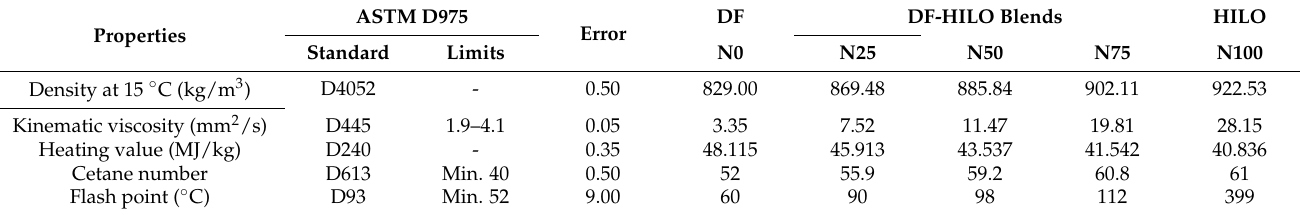
Table 2. Measured the physical-chemical properties of the test